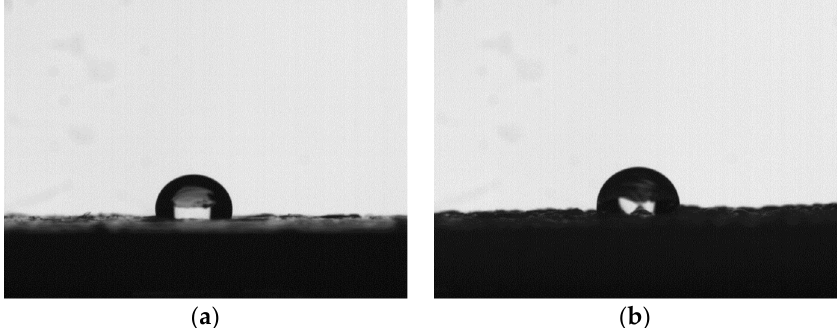
Figure 7. The images of a water droplet on different positions of ( a ) PLA samples without coating, and ( b ) ABS samples without coating.